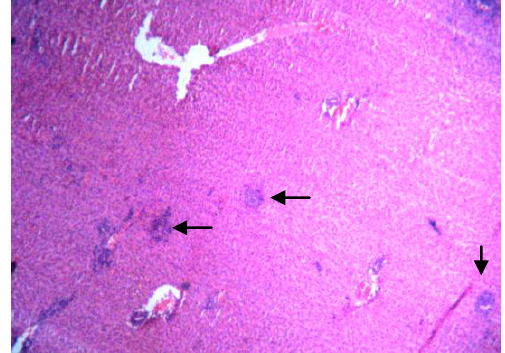
Fig (10): Kidney at 16 hr showed hypercellulirty of the glomeruli ( ) with congestion of blood capillaries of the glomerular tuft ( H&EX10).